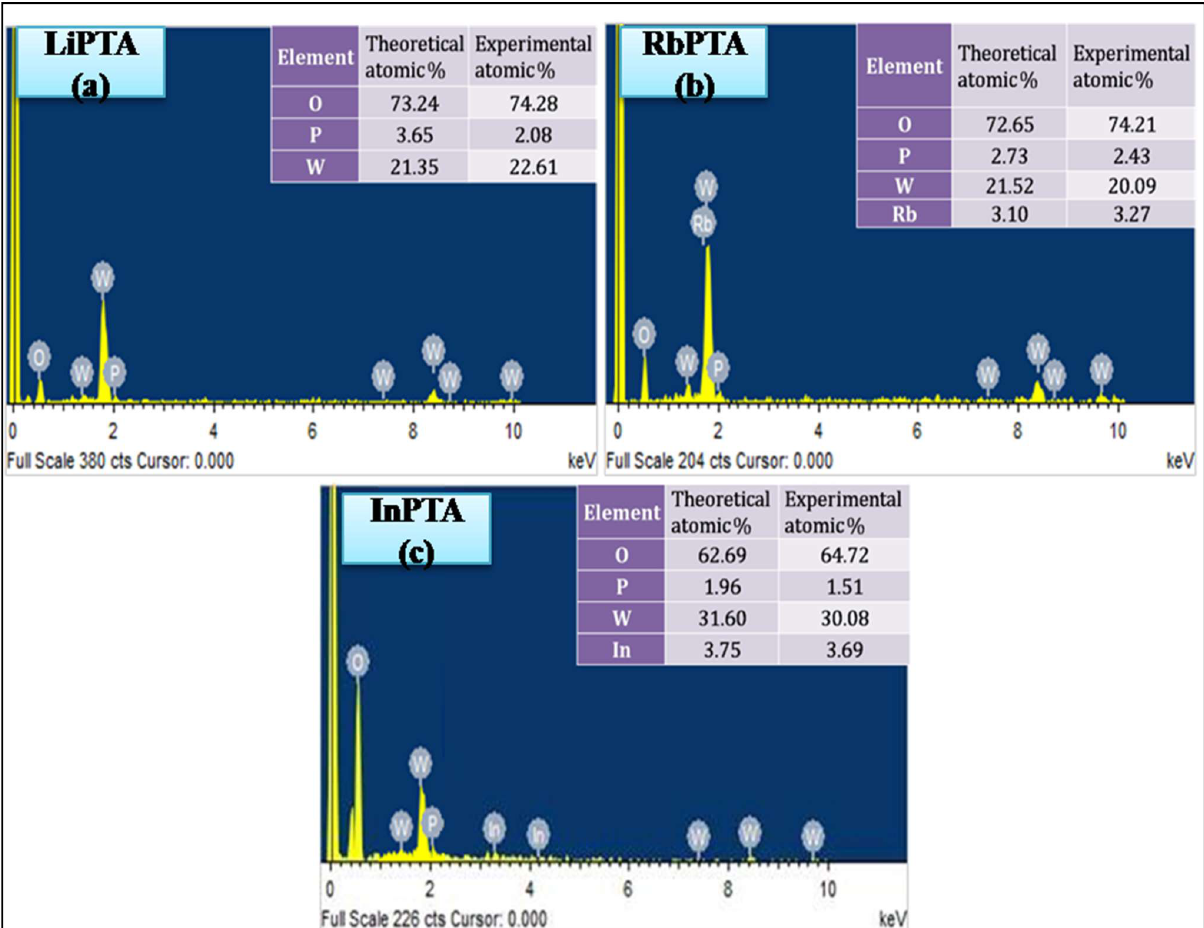
Figure 5. Energy-dispersive X-ray spectra of ( a ) Li−PTA, ( b ) Rb−PTA, and ( c ) In−PTA thin films.